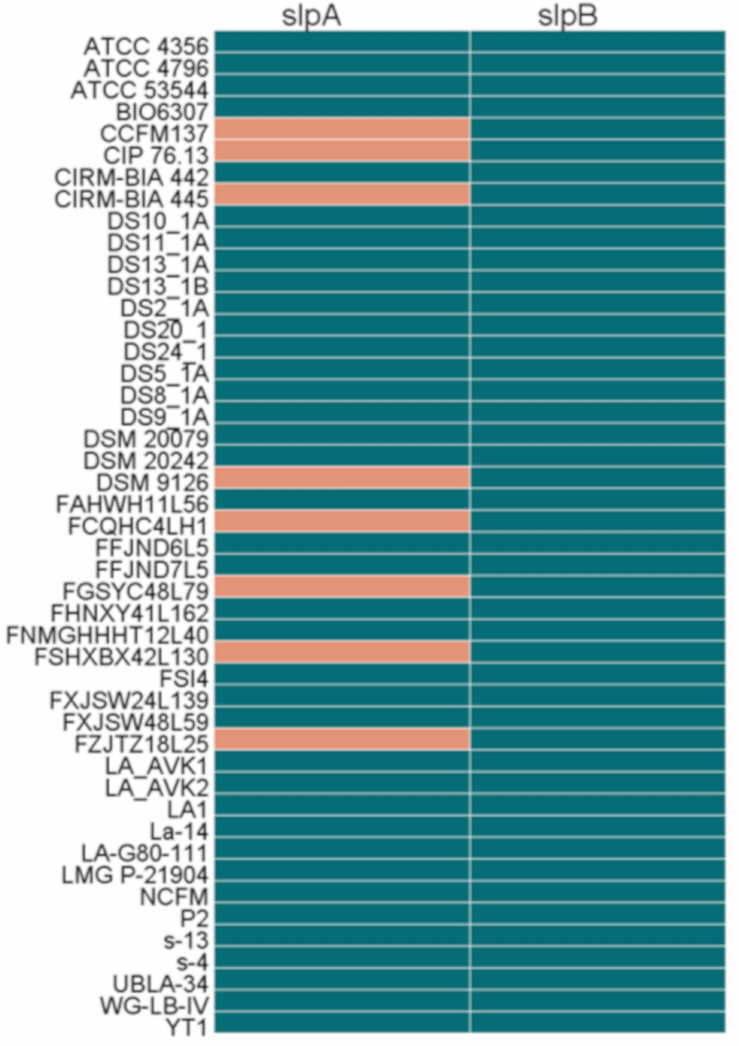
Figure 11. Heatmap of surface layer protein gene in L. acidophilus . Black green regions represented the specific genes exist in strains. The orange regions represented the specific genes do not exist in